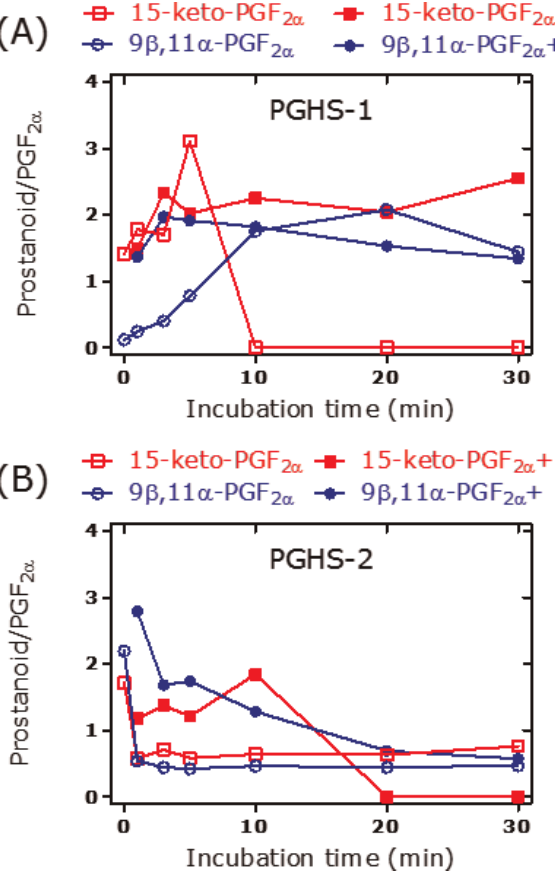
Figure 3. PGE 2 and prostanoids (PGs, PGD 2 +15-keto- PGF 2 α +9ß,11 α -PGF 2 α +PGF 2 α +8- iso -PGF 2 α ) formed in incu- bation mixtures of arachidonic acid (10 µM), recombinant PGHS-1 (5 U), or recombinant PGHS-2 (5 U) at 37°C for the indicated time points. (a) Amount of PGE 2 and PGs per pg PGHS-1 or pg PGHS-2. (b) Molar ratio of PGHS-1- to PGHS-2-derived PGE 2 , PGs, and their molar ratio. Experi- mental conditions and prostanoids analysis were as described elsewhere (3). of the thiol N -acetyl-L-cysteine (Figure 2B) or glutathione (Figure 2C), the decomposition of PGH 2 to PGE 2 decreases, while the formation of F 2 -prostanoids such as 8- iso -PGF 2 α , 9 β ,11 α -PGF 2 α , 15-keto-PGF 2 α , and PGF 2 α increases several fold. On the contrary, thiols seem not to affect decomposition of synthetic PGG 2. Similar effects are also seen in the presence of recombinant PGHS-1 or PGHS-2, yet in the absence of synthetic PGG 2 or PGH 2 , in a manner depending on the incu- bation time (Figures 3 and 4). These observations indicate that certain changes in experimental conditions may affect signi fi cantly the pattern of prostanoids and consequently of their molar ratios (Figure 4). Diverging results are also obtained using PGHS inhibitors with different modes of action such as acetylsalicylic acid (irreversible inhibitor) or diclofenac and indomethacin (both reversible inhibitors) (3).